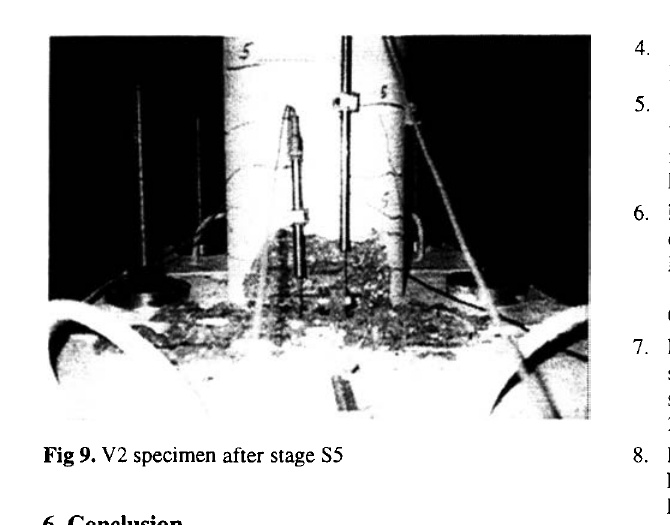
Fig 9. V2 specimen after stage